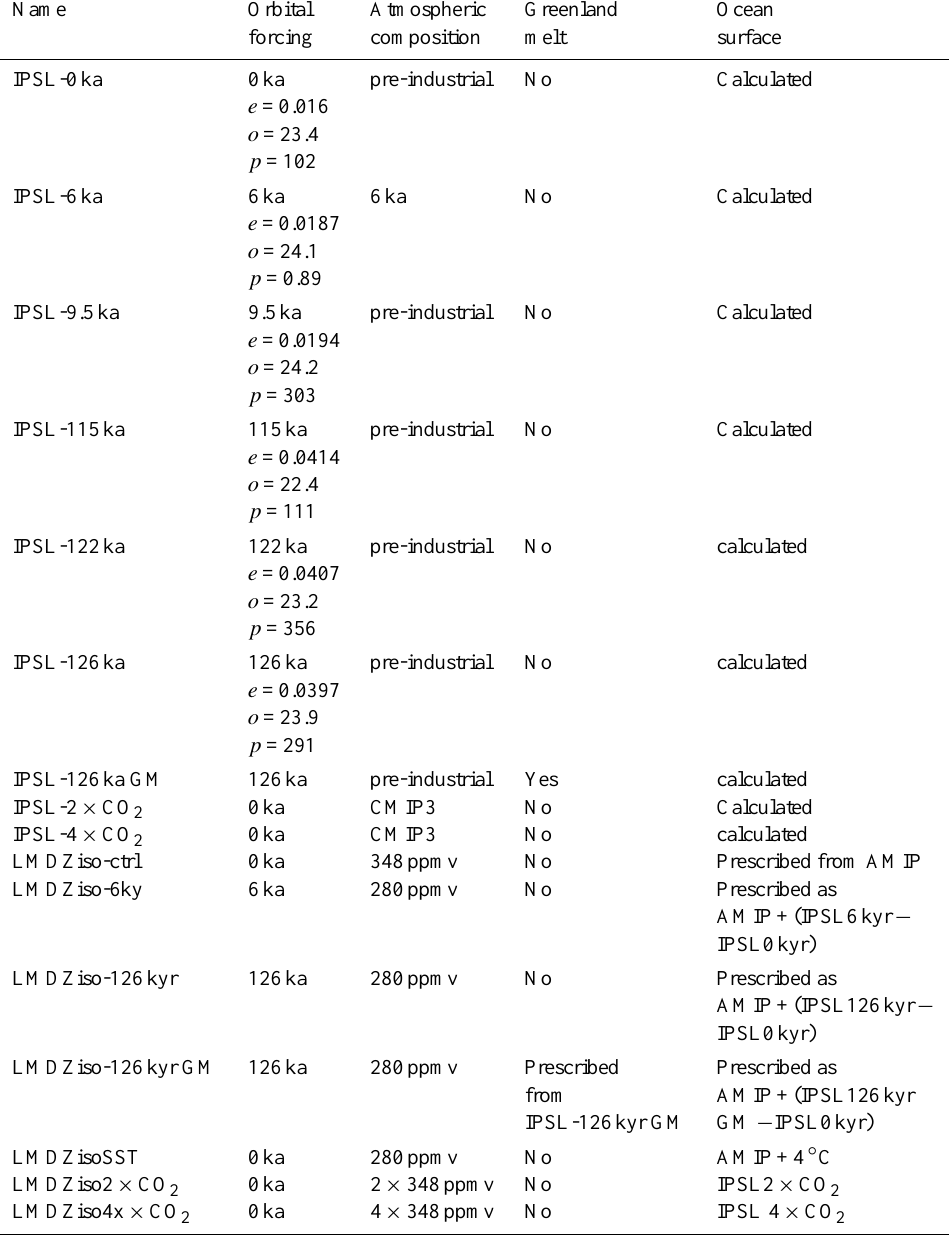
Table 1. Description of the simulations. The LMDZiso simulations were run for 5 years with climatological forcing averaged from the IPSL-CM4 ouputs, and results analysed for the last 3 years of this simulation. AMIP (Atmospheric Modelling Intercomparison Project) boundary conditions are derived from observed SST and sea-ice (1979 to 2007). Atmospheric composition refers to prescribed changes in greenhouse gas concentrations (e.g. CO 2 ). In the orbital forcing column, e , o and p respectively stand for eccentricity, obliquity (in ◦ ), and perihelia-180 ◦